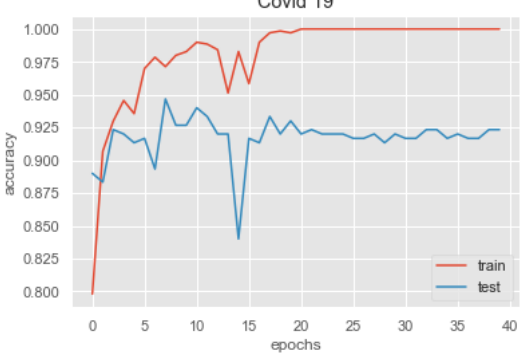
Figure 7 . Accuracy for the training and test data.